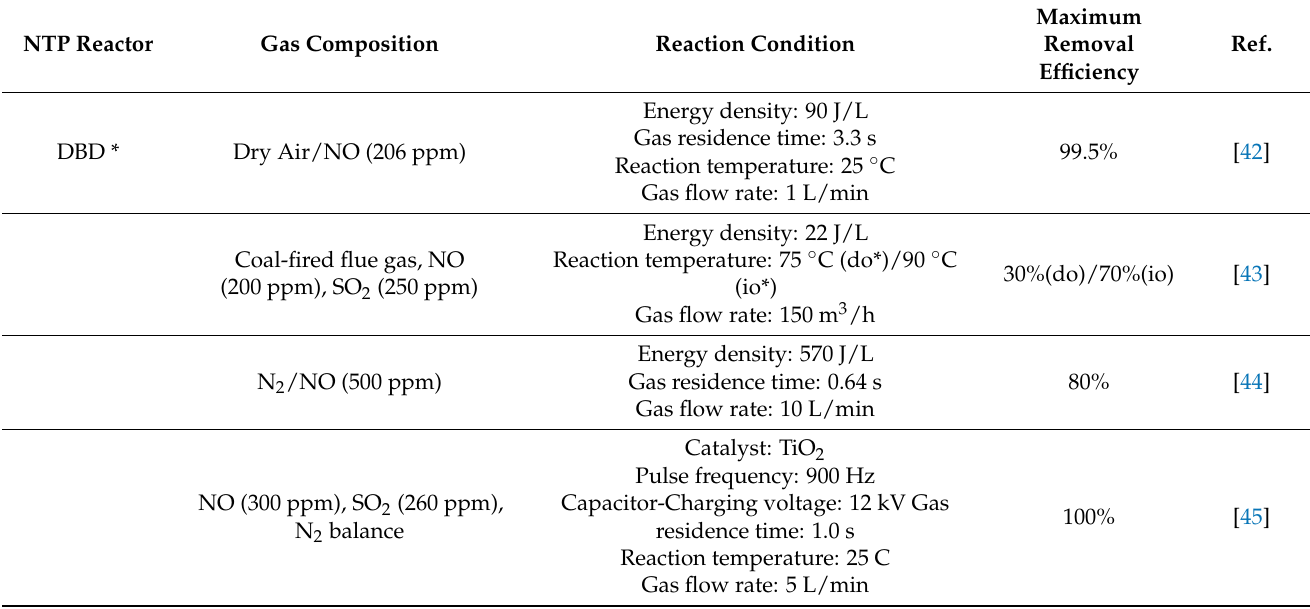
Table 2. Experimental conditions and removal efficiencies of available NTP processes for NO